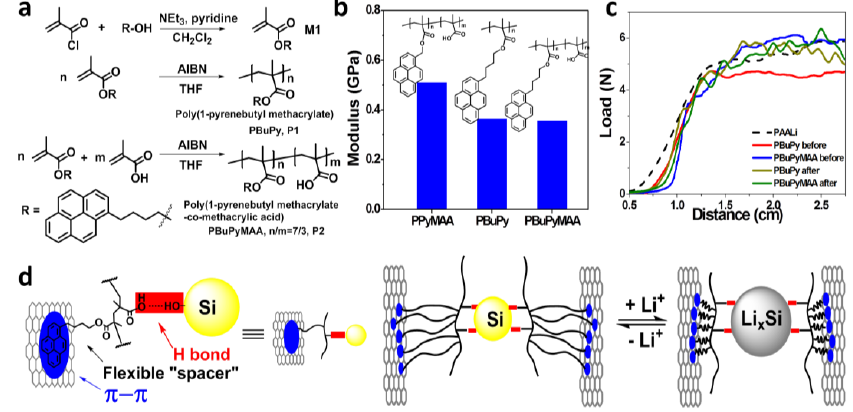
Figure 1. ( a ) The synthesis to Poly(1-pyrenebutyl methacrylate) (PBuPy) and